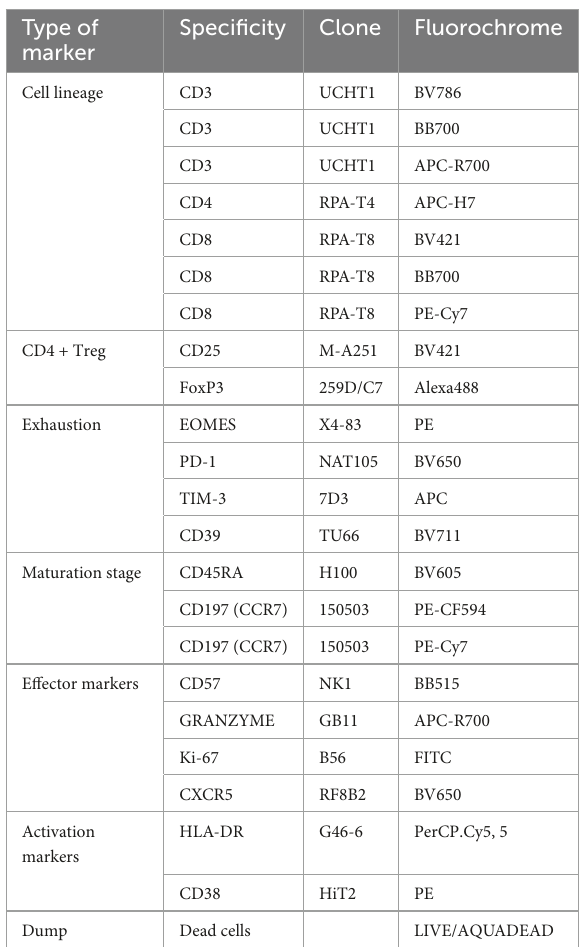
TABLE 1 Reagents used for T cell